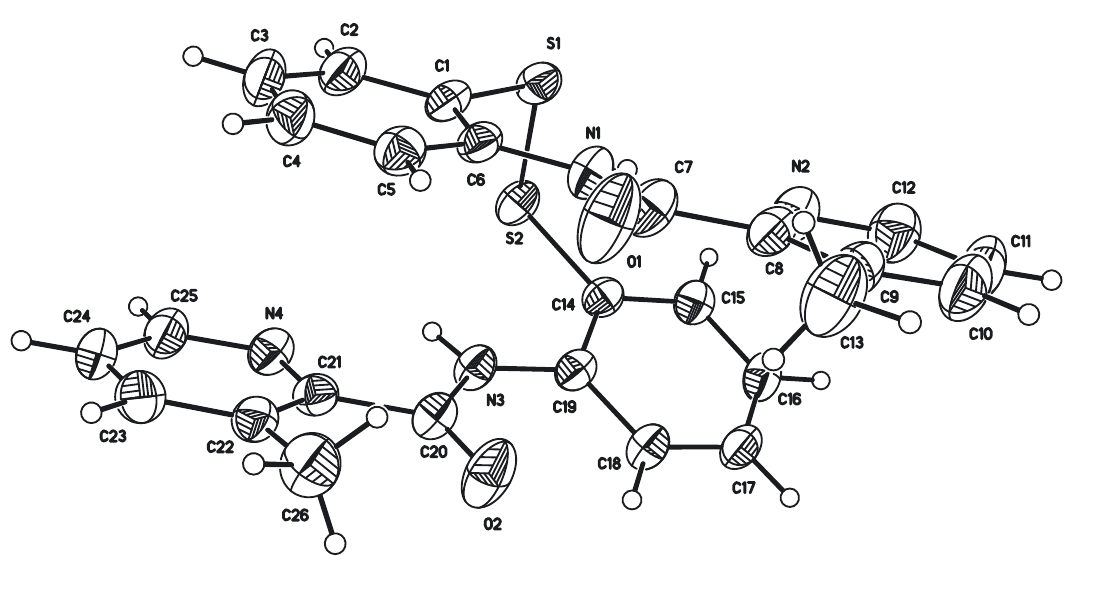
Table  : Data collection and